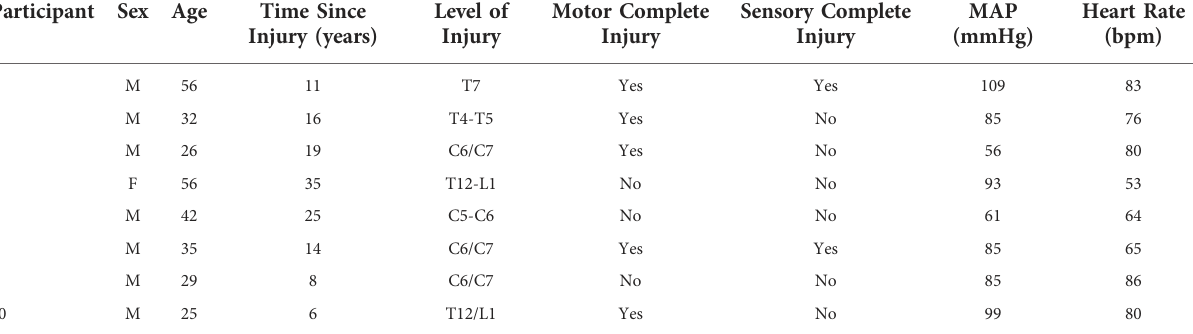
TABLE 1 Participant characteristics.